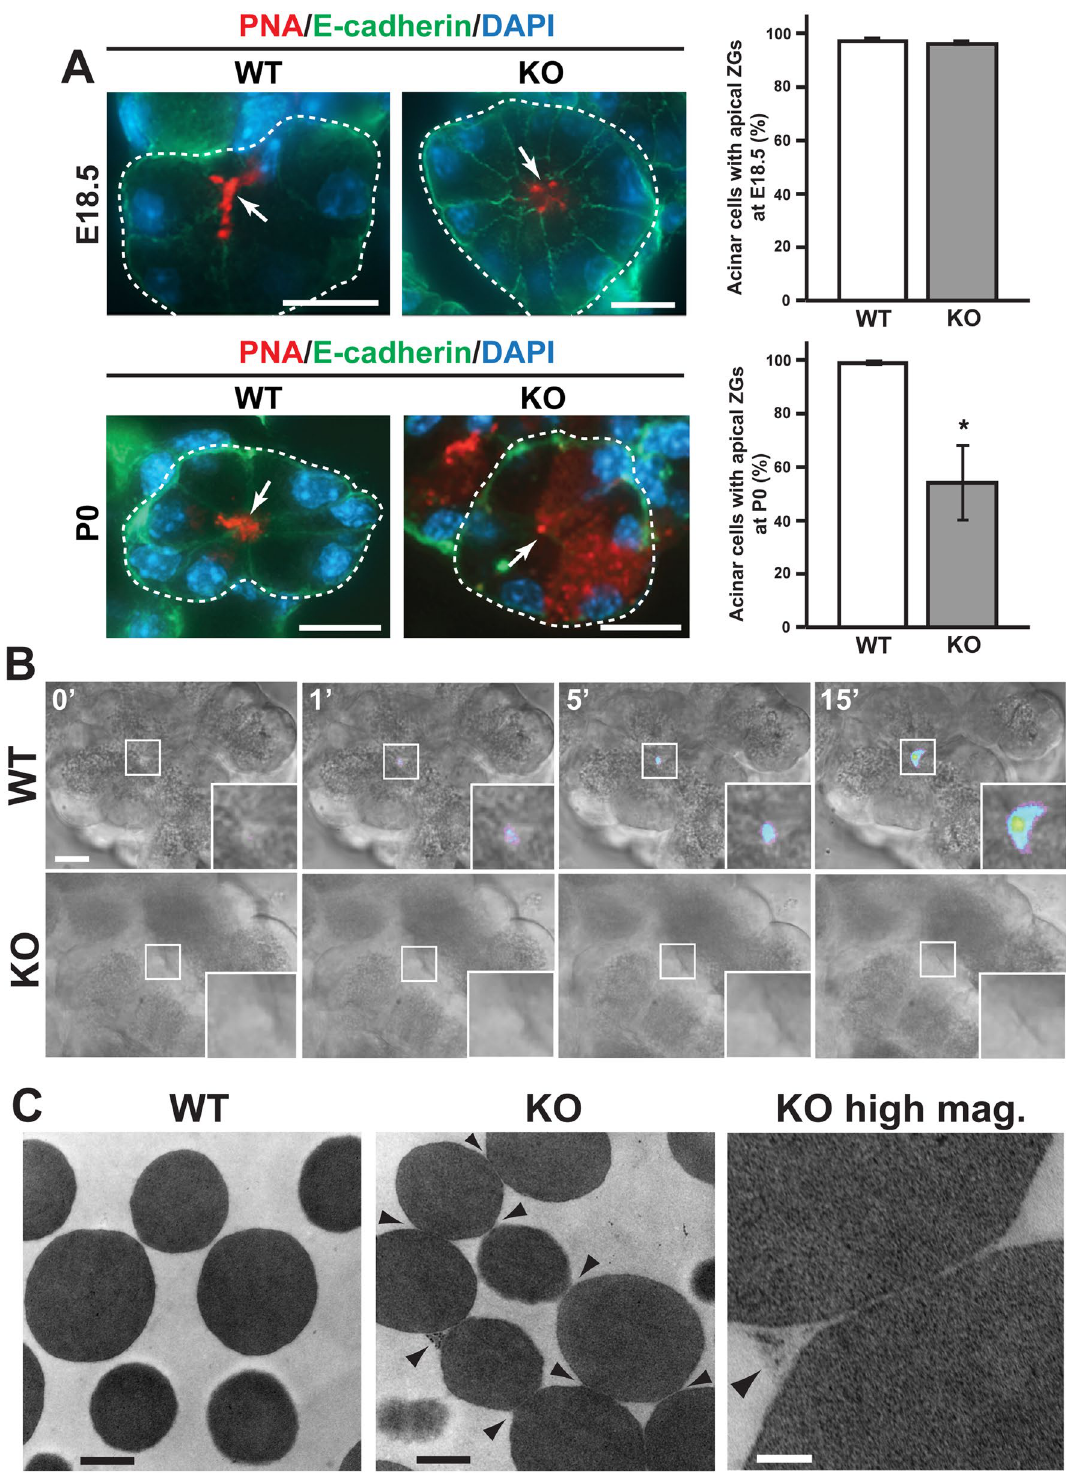
Figure 8. Defective ZG polarity and exocytosis in Cby1-KO acinar cells. ( A ) Pancreatic sections from E18.5 and P0 mice were labeled with PNA-lectin (ZG marker, red) and E-cadherin antibody (basolateral membrane marker, green) as indicated. Nuclei were visualized by DAPI. Acini are encircled with dotted lines. The apical lumen is indicated by arrows. The quantification of acinar cells with apical ZGs is shown on the right. More than 200 cells were counted per age for each genotype. Data represent means ± SEM. *p < 0.05. ( B ) Acini were isolated from the pancreas of adult mice, incubated with FM1-43, and stimulated with cerulean at time 0. Images were taken 1 frame/min for ~ 30 min. Representative sequence images in pseudocolor are shown to better visualize the fluorescent intensities. The squared areas with the apical pole of an isolated acinus are enlarged in the insets. Scale bars, 10 μm. ( C ) ZGs purified from adult pancreata were subjected to TEM. Note that ZGs from Cby1-KO acinar cells were interlinked with each other by a proteinaceous material (arrowheads). Scale bars: 500 nm; KO high mag., 100